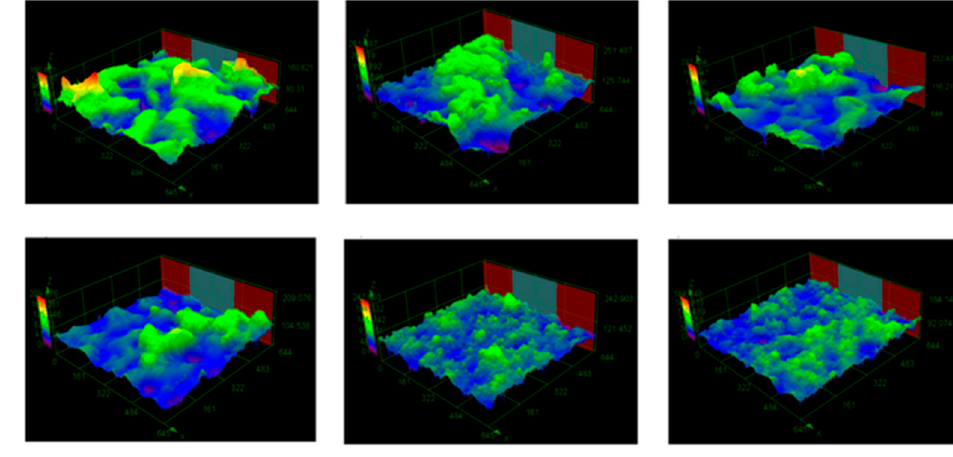
Figure 14. Cloud map of roughness distribution of double-layer reflow microchannel.